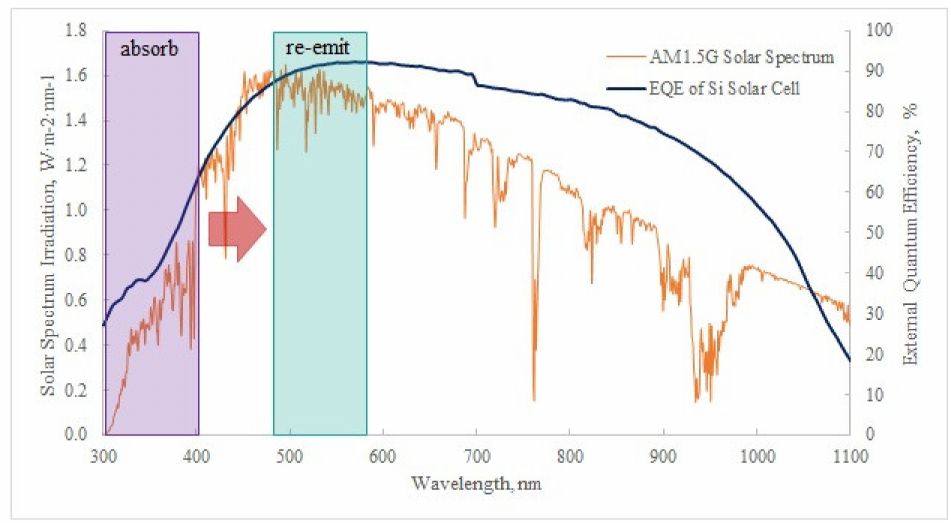
Figure 1. The idea of DS process in solar cell. The UV part of solar spectrum radiation is not used by silicon solar cell efficiently; hence, the DS layer is shifting radiation to the range effectively matched to solar cell